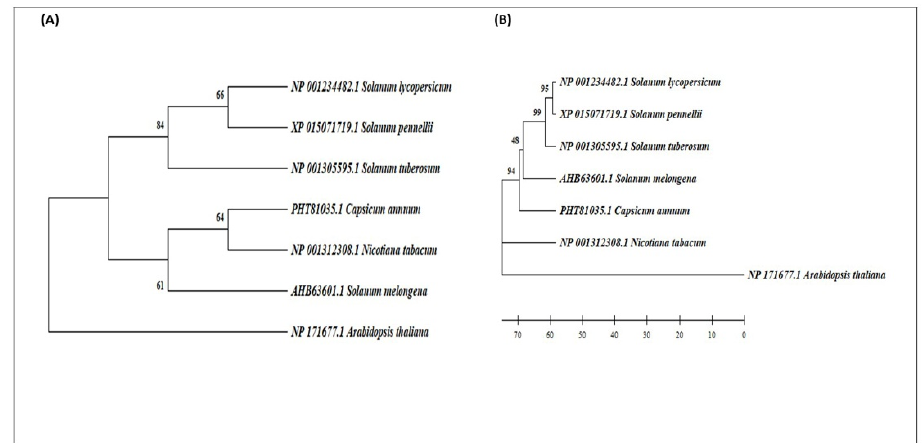
Figure 1. Phylogenetic tree showing ( A ) neighbour-joining ( B ) maximum parsimony of Solanum lycopersicum SlNAC1 protein among different members of the solanaceous family and model plant A. thaliana.